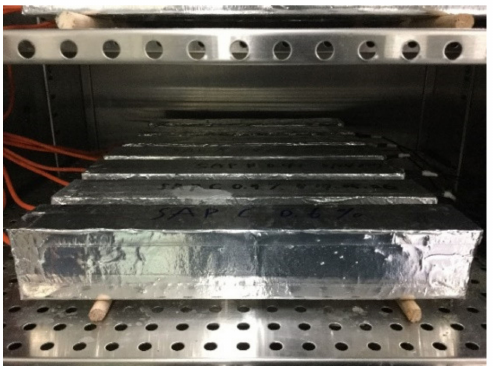
Figure 5. Autogenous shrinkage and IRH measurements in